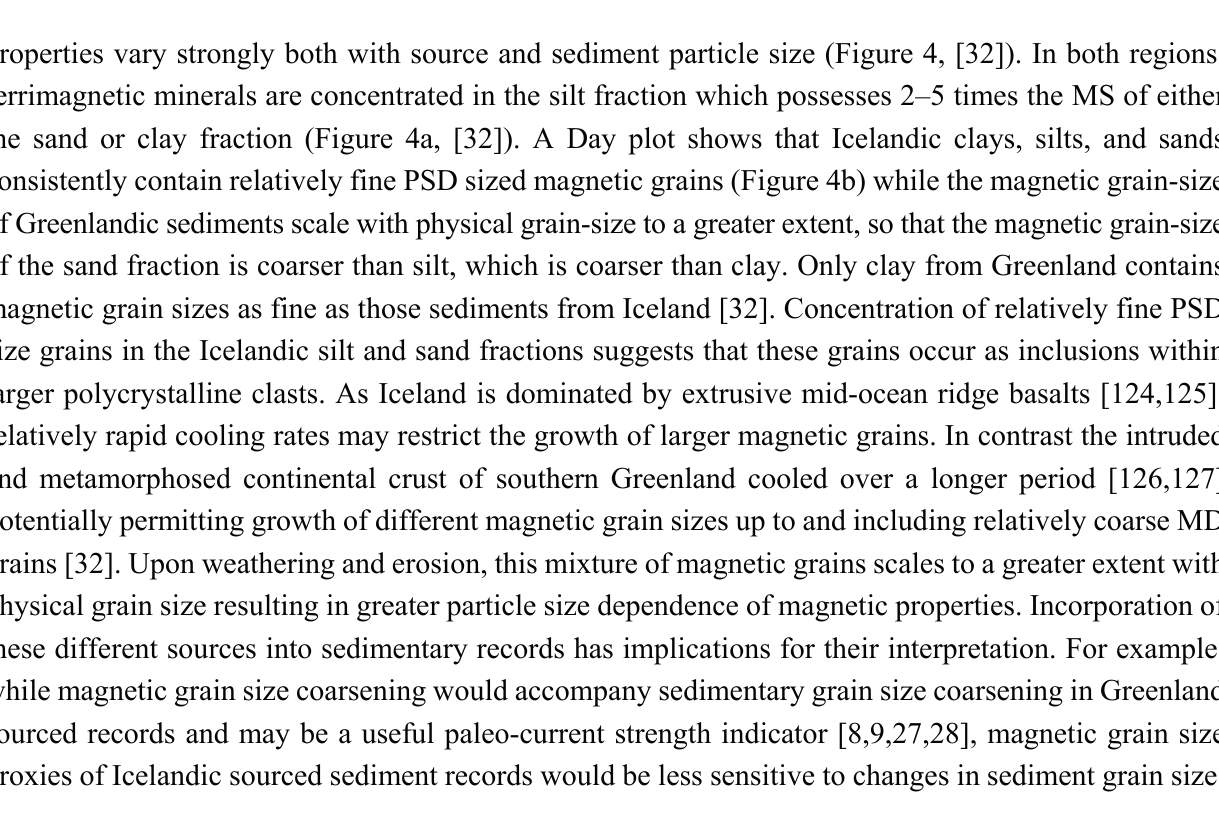
Figure 4. Variation of terrestrial magnetic properties with grain size: ( a ) Magnetic susceptibility (MS) (one standard deviation range about the mean) of six particle size fractions from Greenland and Iceland. Note how the MS of silts (10–63 μ m) are 2–5 times higher than fine silt/clay (<10 μ m) or sand (>63 μ m) fractions. ( b ) Day plot (Day et al. [92]) of clay (<3 μ m), silt (3–63 μ m), and sand (>63 μ m) fractions from Greenland (green data) and Iceland (black data). Note that all Icelandic fractions possess relatively similar fine pseudo single domain (PSD) magnetic grain sizes. In contrast, only Greenland clays possess the same magnetic grain size as Iceland samples, Greenland silts and sands fall further along the SD/MD (super-paramagnetic/multi-domain) mixing line possessing higher concentrations of coarser PSD and MD grains. ( c ) Silt data from ( b ) highlight the discrimination of source afforded by this fraction. Boxes on the y -axis show the range of Mrs/Ms values from different sources. All data from Hatfield et al.